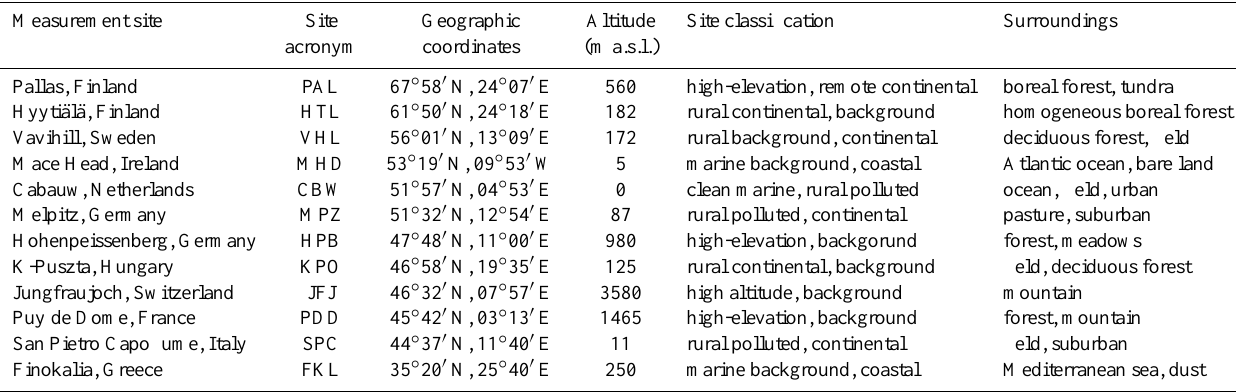
Table 1. Short description of the measurement sites within the EUCAARI project relevant to this study. The location of the field site, site acronym, geographic coordinates, and site altitude in meters above sea level are shown. The site classification describes the geographical lo- cation and the pollutant gases as well as the aerosol particle concentrations at the site. The surroundings column characterizes the dominating landscape type surrounding the site.